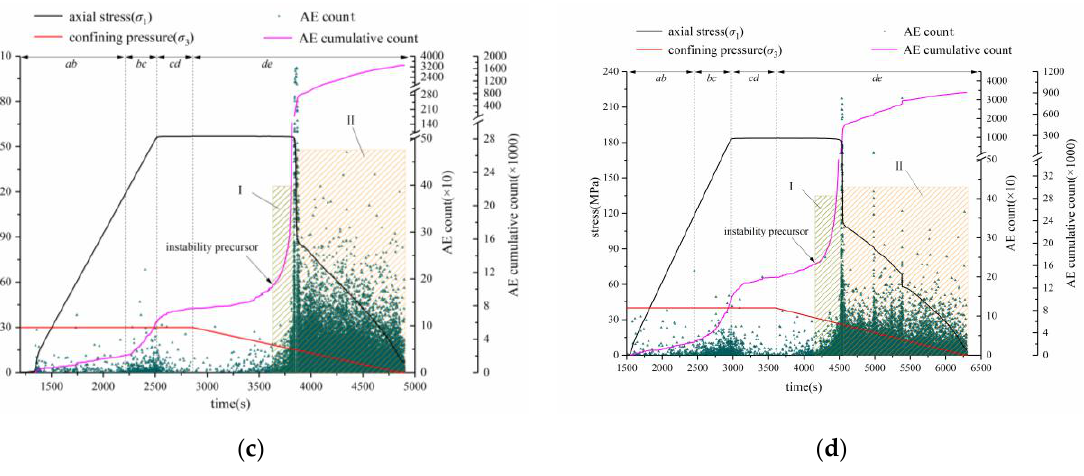
Figure 7. Stress-AE counting relationship of samples. ( a ) σ 3 = 10 MPa; ( b ) σ 3 = 20 MPa; ( c ) σ 3 = 30 MPa; ( d ) σ 3 = 40 MPa.